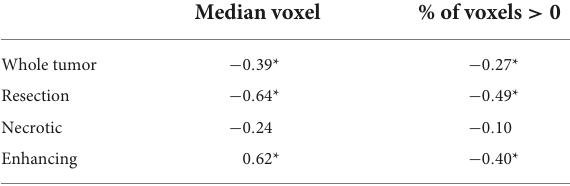
FIGURE5 A distribution of the experts’ ratings for the glioblastoma multiforme (GBM) segmentation using the uncertainty values. Seventy-two percent of the segmentation results were rated "acceptable as is for treatment planning" (5) or better (scores 6 and 7). TABLE 3 Spearman correlation between uncertainty and accuracy